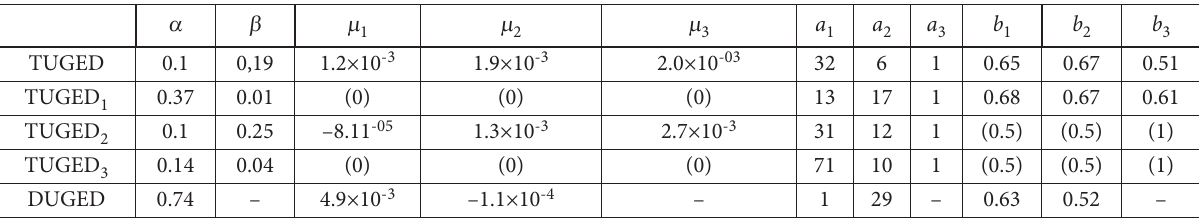
Table 3. Results of TUGED parameters